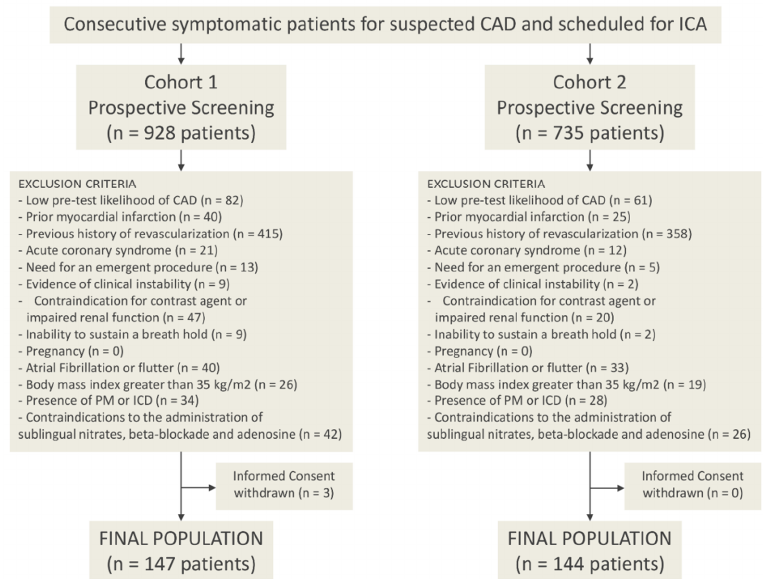
Figure A1. Study flow diagram. Consecutive symptomatic patients referred for suspected CAD and scheduled for clinically indicated ICA were screened. After the application of inclusion and exclusion criteria, 291 patients were enrolled, 147 in the first arm, in which Static Stress-CTP was performed, and 144 in the second arm, in which Dynamic Stress-CTP was performed. CAD: coronary artery disease; ICA: invasive coronary angiography; Stress-CTP: stress computed tomography